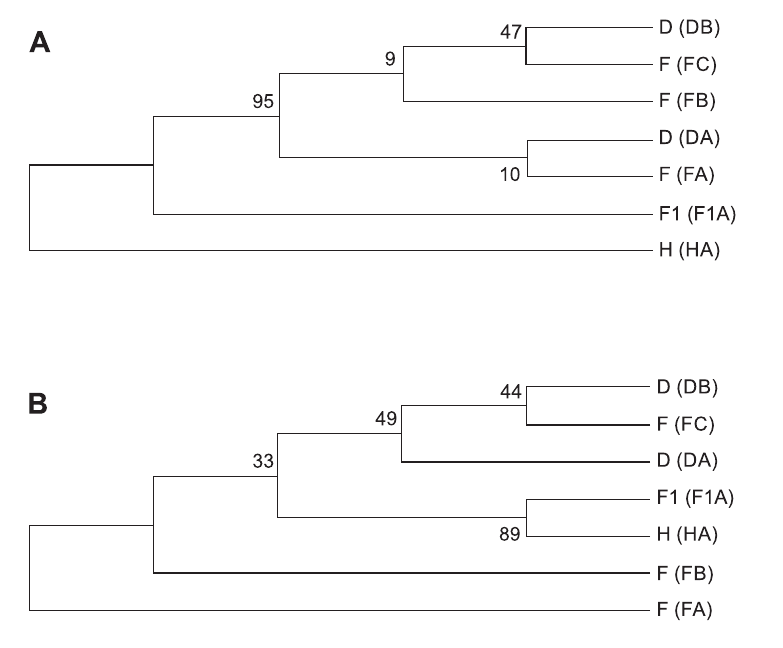
Fig. 3. Phylogenetic tree generated using: ( A ) Maximum Parsimony method (bootstrap = 1000 iterations), ( B ) Neighbor- Joining method (Kimura’s 2-parametric model, bootstrap = 1000 iterations), showing the relations between the haplotypes of perch, Perca fluviatilis , occurring in the investigated